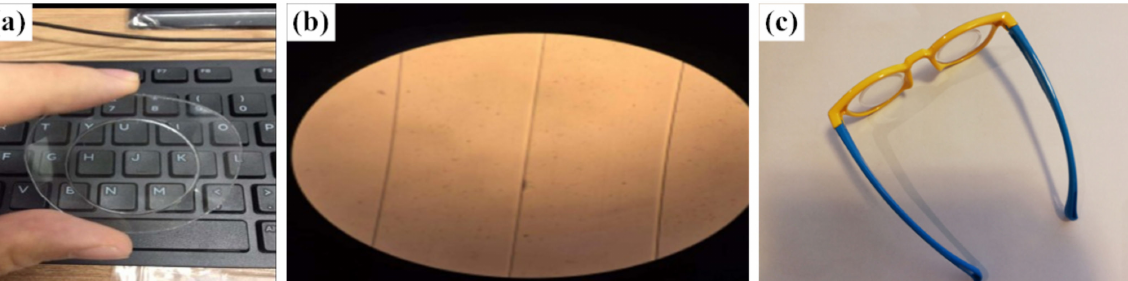
Figure 7. ( a ) Photograph of a sample of the PMMA microprism we fabricated; ( b ) partially enlarged view of the microrelief under an optical microscope; ( c ) photograph of the fabricated PMMA anti- fatigue glasses based on microprisms for preventing